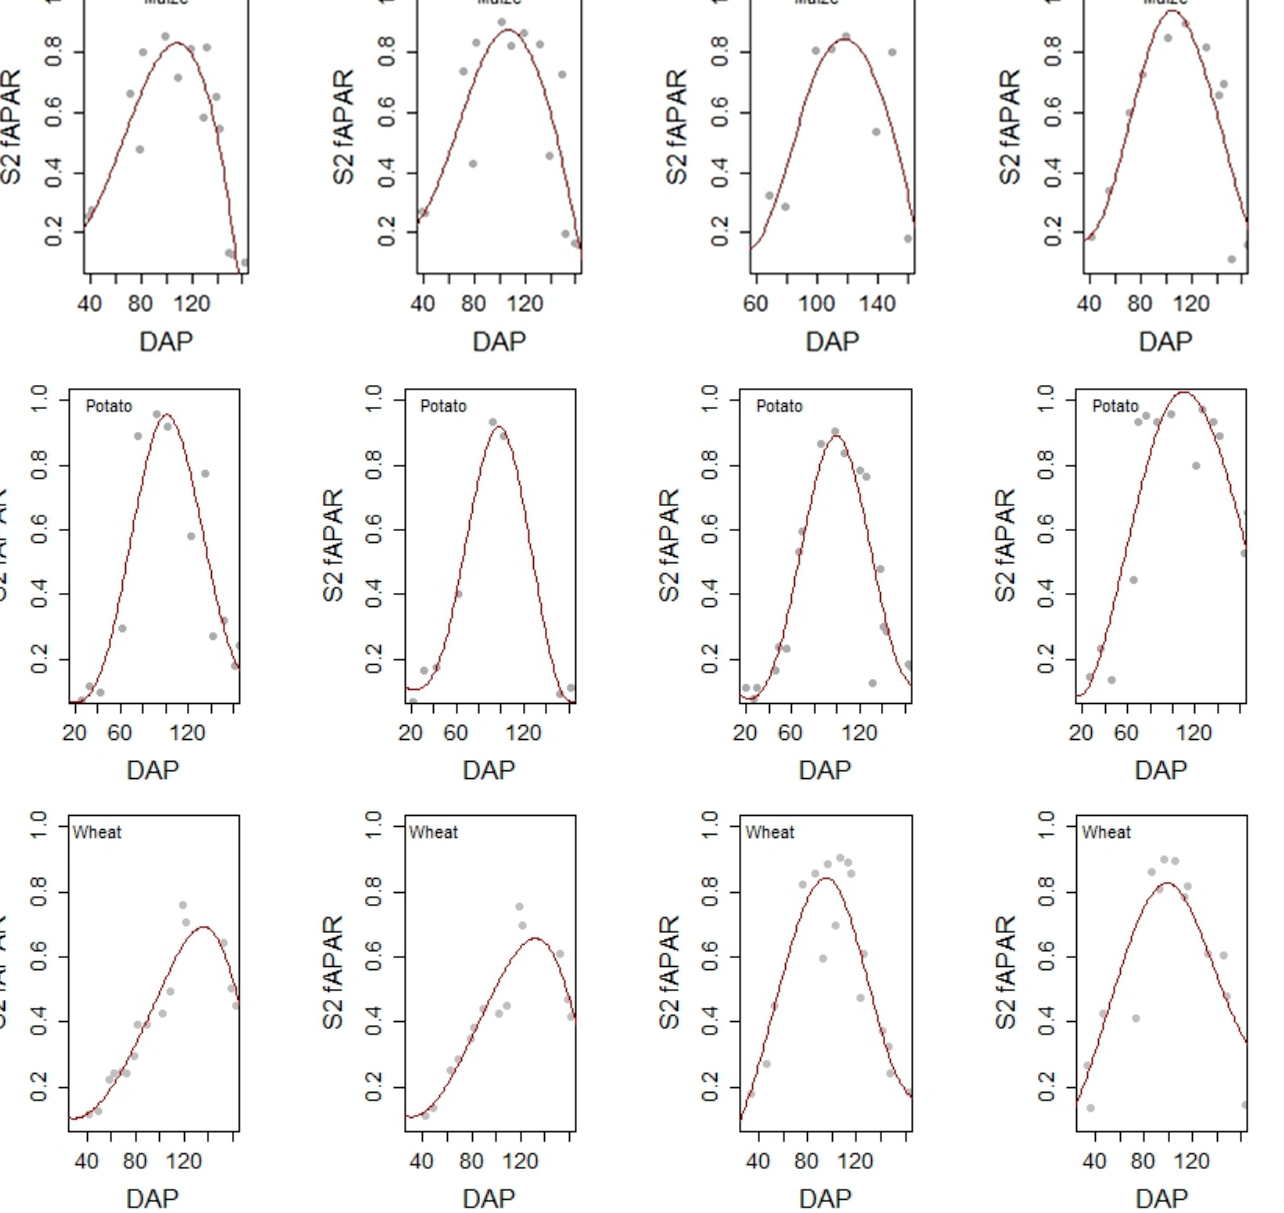
selected fields of maize, potato, and winter wheat during the 2017 growing season.